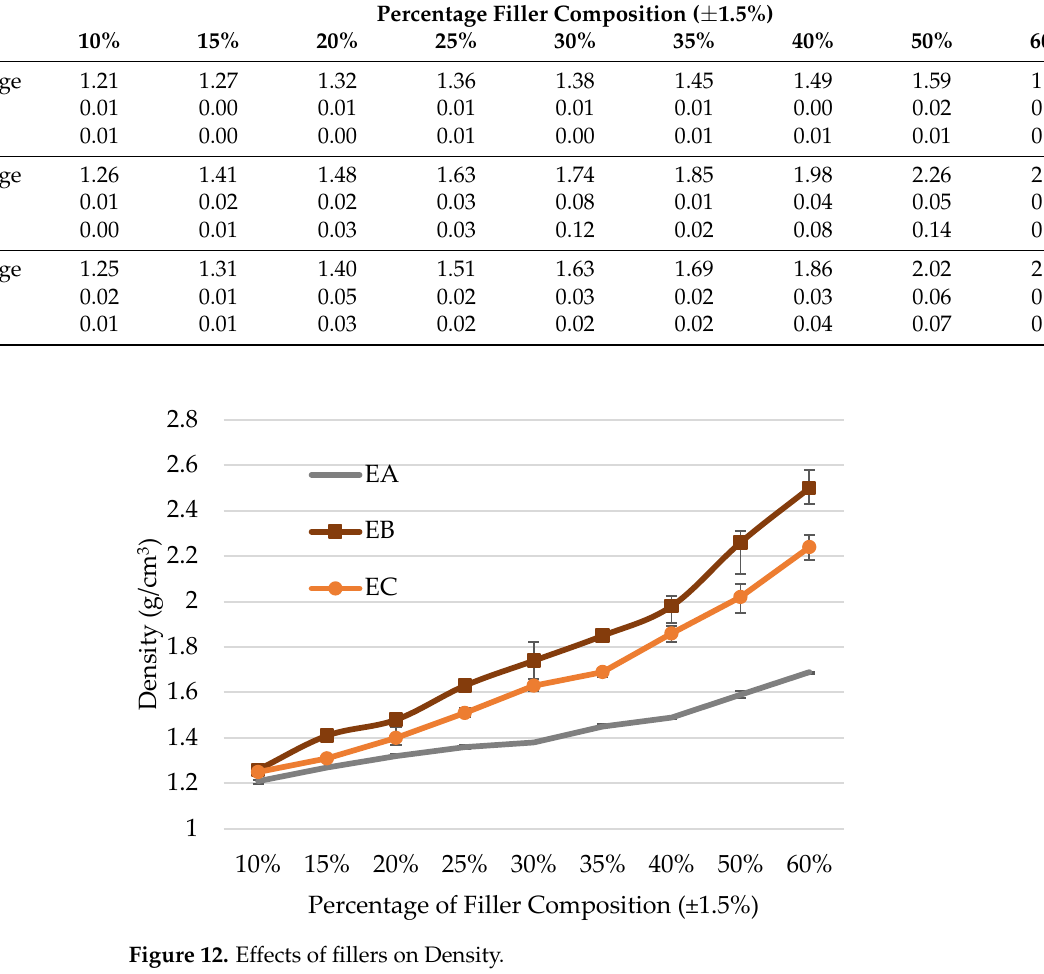
Table 7. Summary of Vickers hardness values for EA, EB, and EC.